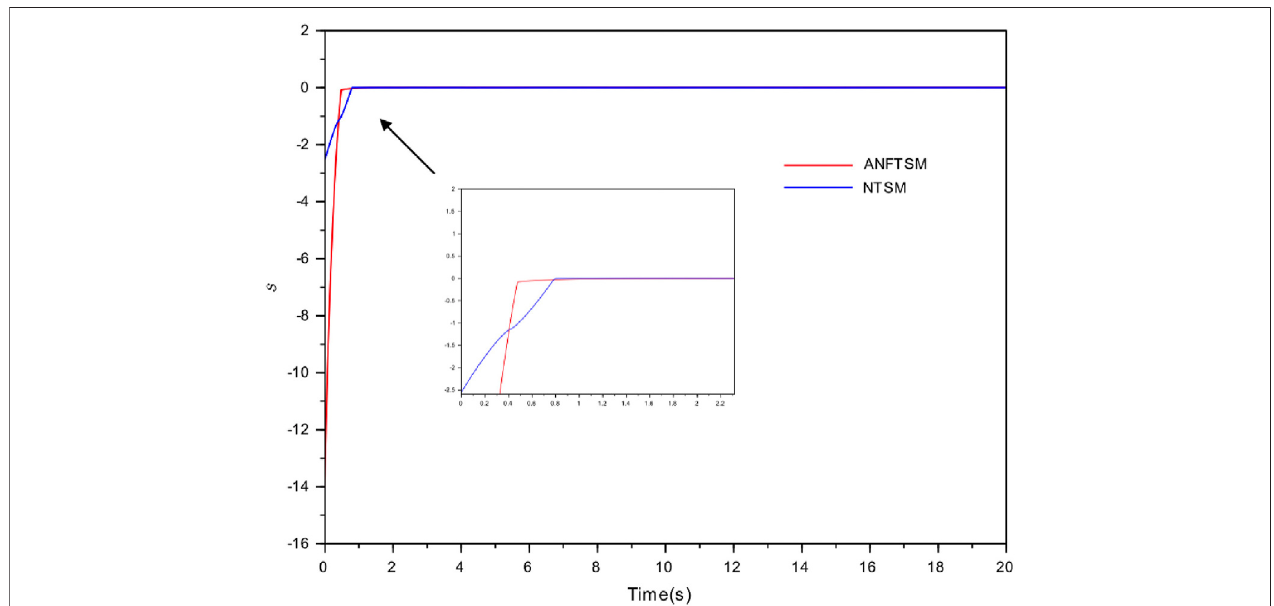
FIGURE 10 | Sliding surface for Example 2.